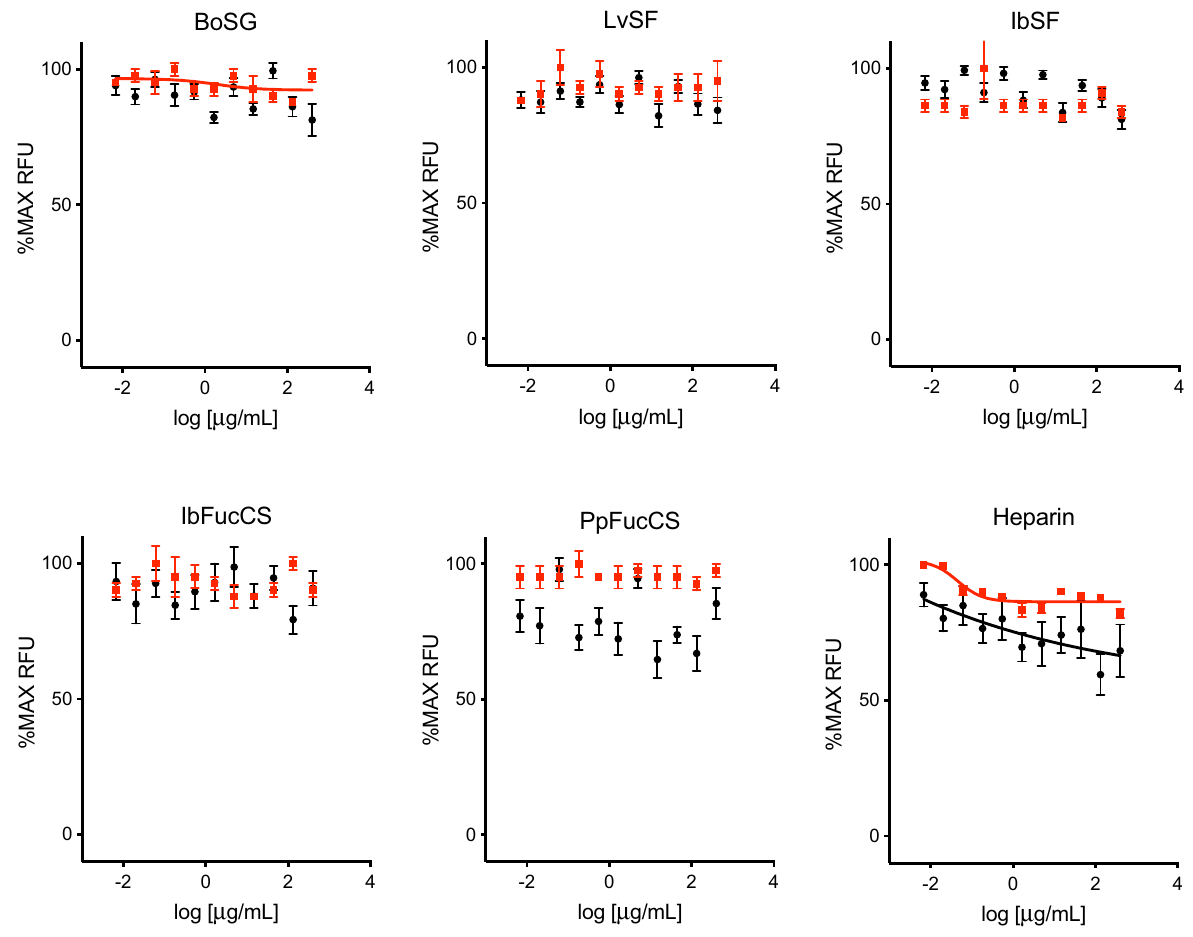
Figure 4. Antiviral activity of MSGs against IAV. Anti-IAV activity (black) and cytotoxicity (red) were measured as described in Fig. 2, except using IAV HA-pseudotyped VLPs and HEK-293T